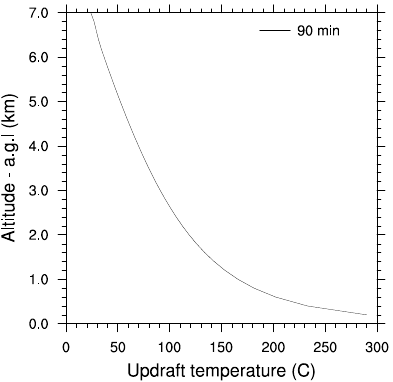
Figure 7. Updraft temperature ( ◦ C) at 90min in the MEDKF simu- lation of Fig.